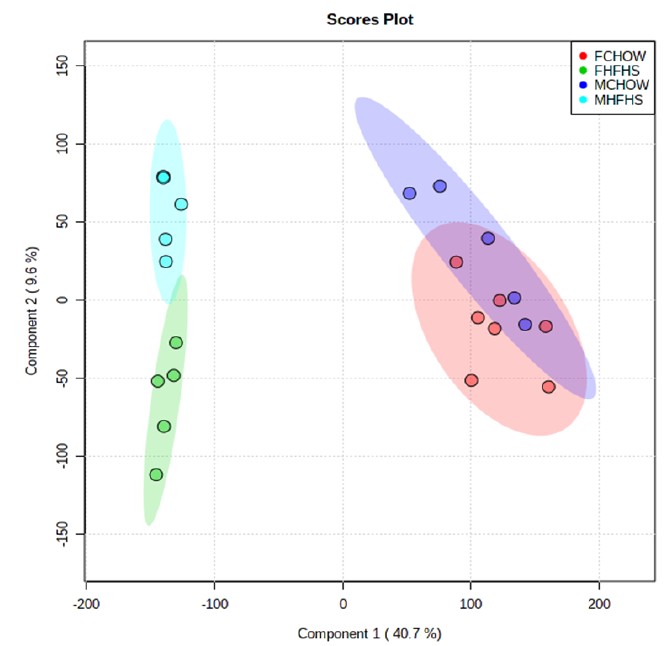
Figure 1. Partial Least Sums Discriminate Analysis (PLS-DA) of the Cecal Metabolome in Female and Male Mice on a CHOW or High Fat/High Sugar (HFHS) Diet. Cecal metabolites from mice on either diet were acquired using untargeted LC-MS/MS analysis and the features were clustered. FCHOW: female mice, chow diet; FHFHS: female mice high fat/high sugar diet; MCHOW: male mice, chow diet; MHFHS: male mice, high fat/high sugar diet. Metabolites 2020 , 10 , x FOR PEER REVIEW